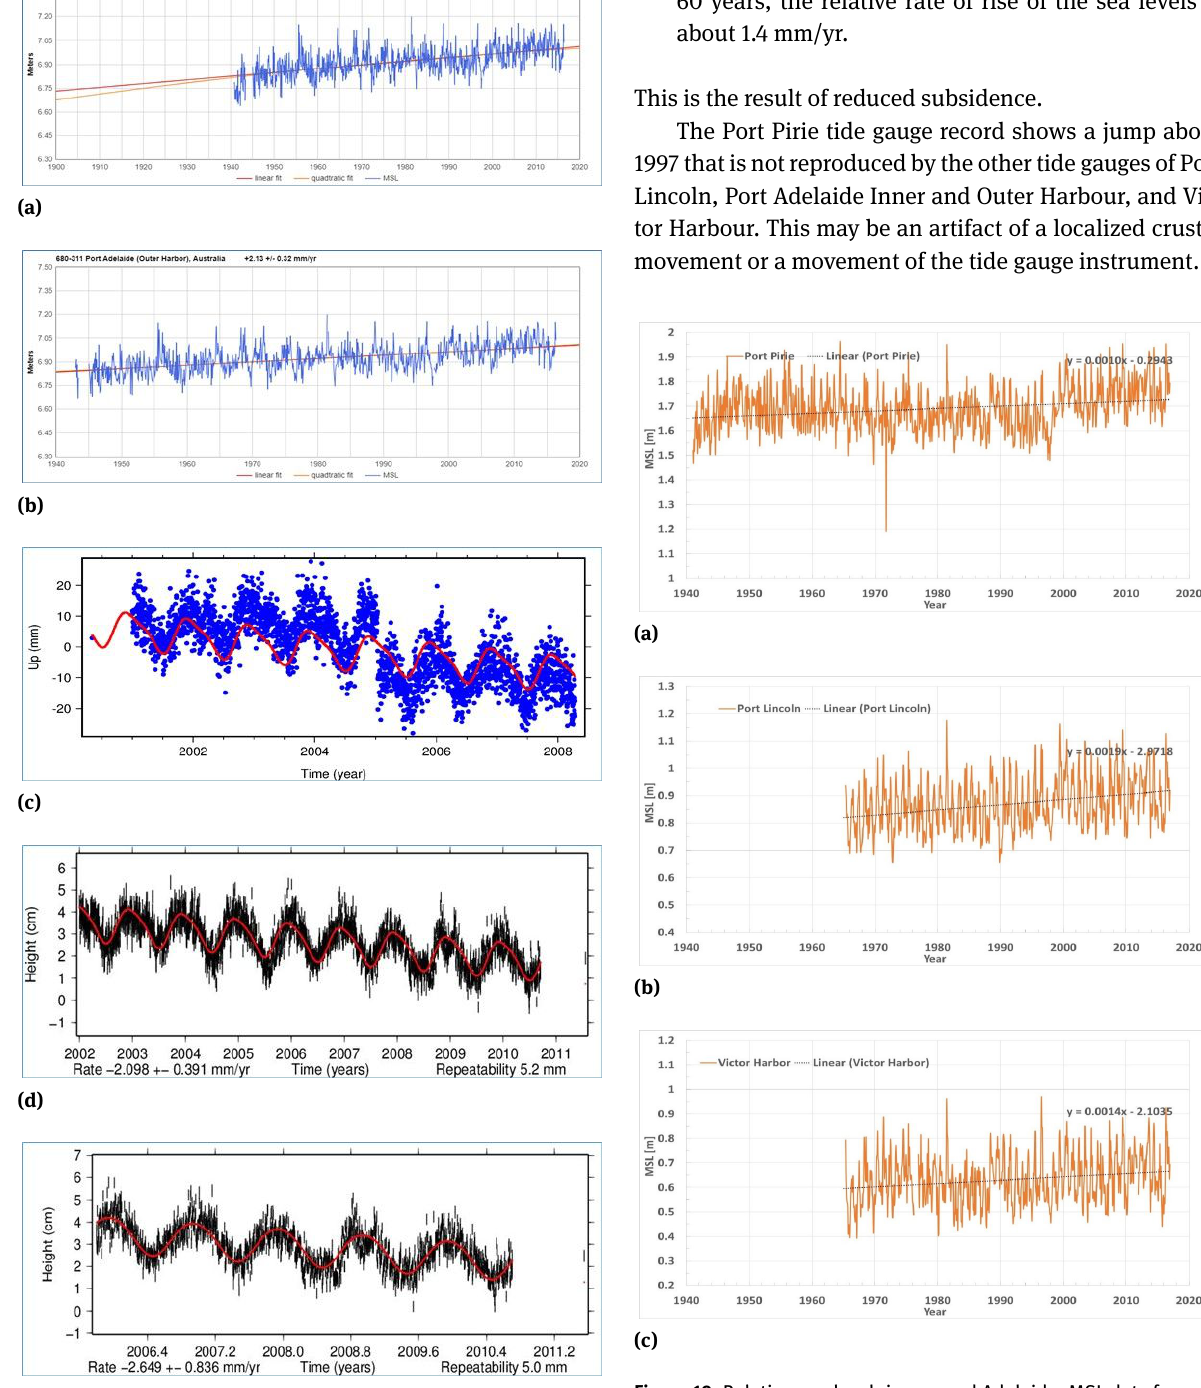
Figure 18: Relative sea level rise (a, b) and land subsidence (c, d, e) for Adelaide. Images modified (a,b) after http://www.sealevel.info, (c) after NGL (S021 GPS antenna), (d) and (e) after JPL (ADE1 and ADE2 GPS antennas).